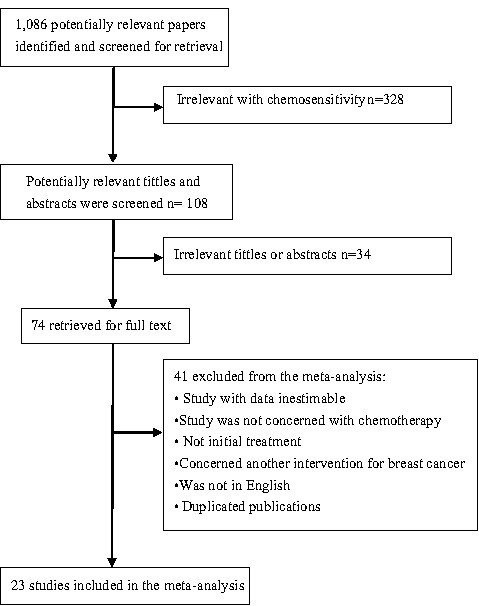
Improving the quality of reports of meta-analyses of randomized controlled trials; the Quality of Reporting of Meta-Analyses (QUOROM) statement flow diagram.